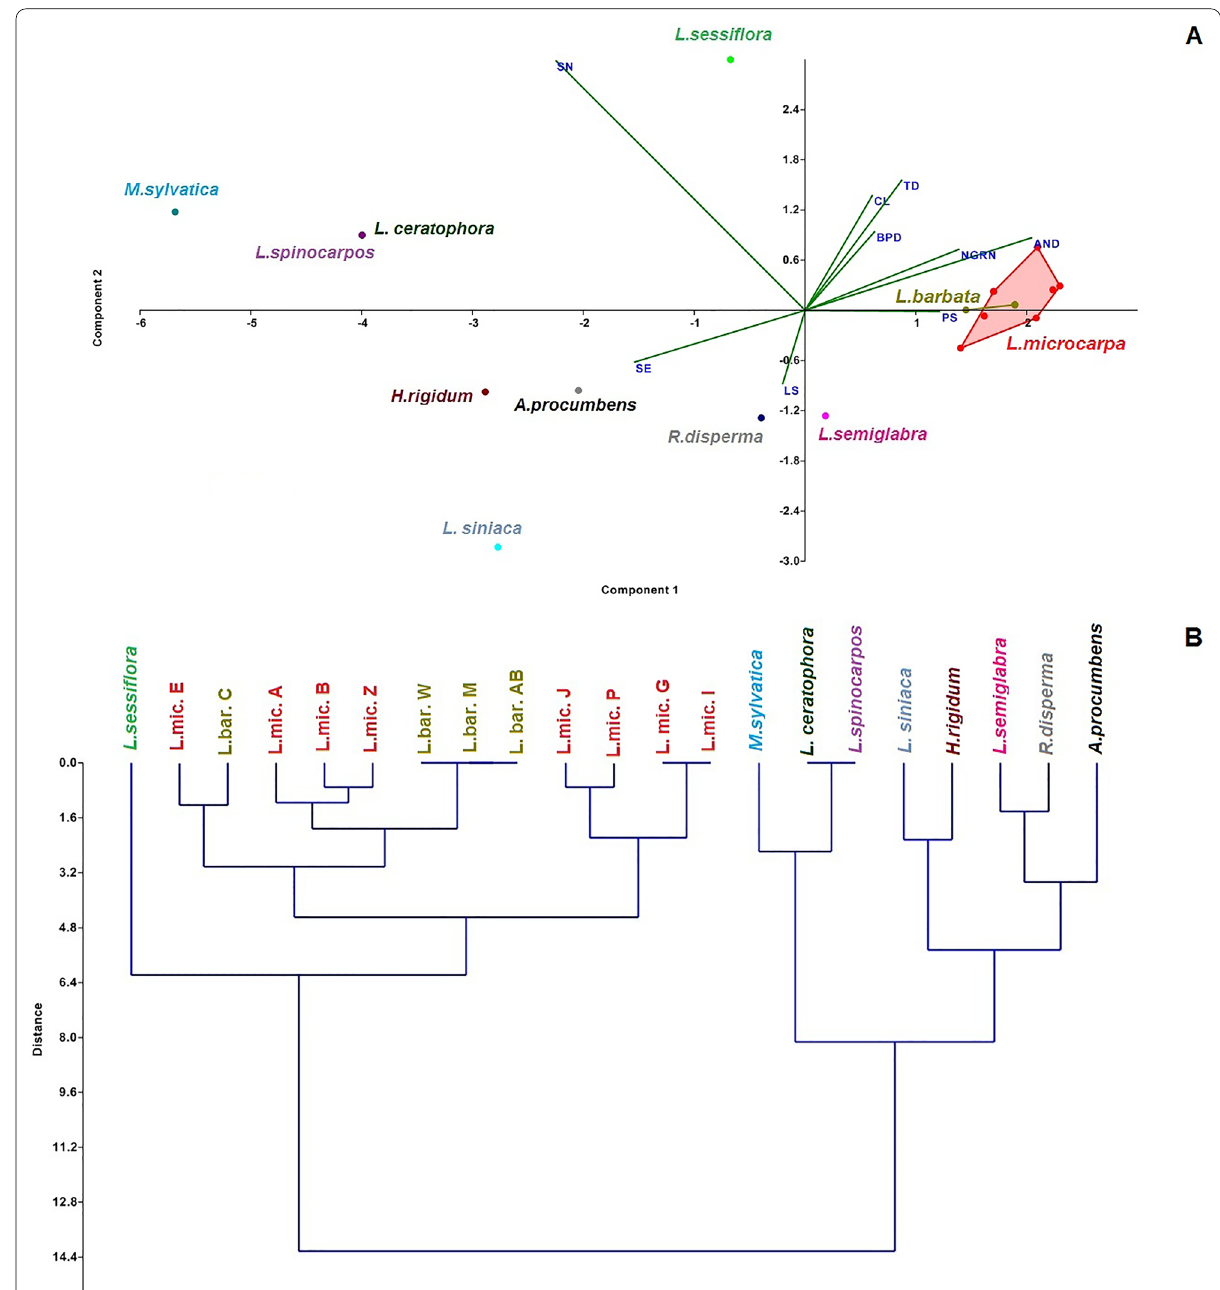
Fig. 4 A PCA Biplot of nutlet characteristics of the studied taxa of Rochelieae tribe focuses on different specimens of L. microcarpa and L. barbata . B WARD dendrogram showing the relationship among different taxa focused on specimens belong to L. microcarpa and L. barbata based on nutlet characters. The codes are in accordance with Table 1. SN (shape of nutlet); CL (centerline of nutlet); BPD (base surface of prickles on the desk; LS (lamella status); AND (appendage on nutlet a desk); NGRN (number of glochid row on nutlet edge); TD (tubercles on a desk); SE (surface emergence); PS (prickles